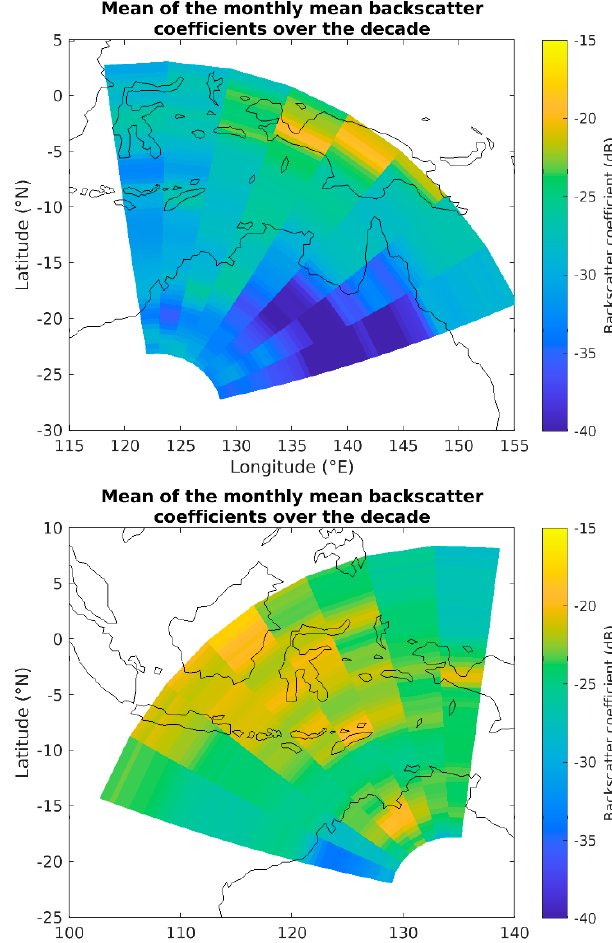
Figure 6. The decade mean of the standard deviation of each monthly value for LO ( top left ), LAE ( top right ), LAW ( bottom left ) and AS ( bottom right ).